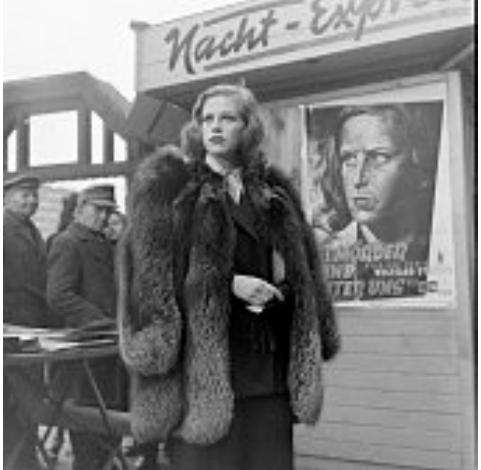
Figure 6. Walter Sanders. Actress Hildegard Knef Walking the Streets of Germany . 1947. The LIFE Picture Collection via Getty Images.